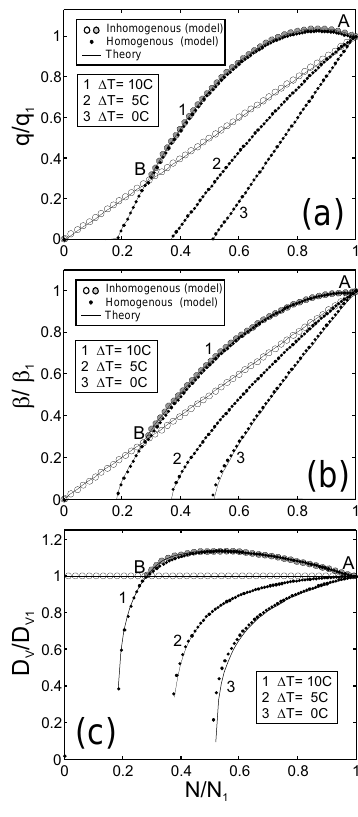
Figure 7. Effect of temperature difference between cloud and en- trained air on mixing. The calculations were performed for initial temperatures T 2 : (1) − 10 ◦ C; (2) − 5 ◦ C; (3) 0 ◦ C. Grey circles in- dicate extreme inhomogeneous mixing on line 1 at the AB inter- val. The rest cases on extreme inhomogeneous mixing are indi- cated by open circles. The initial conditions used for the calcula- tions were the following: H = 1000m, RH 2 = 90%; D 1 = 10µm, N 1 = 500cm − 3 , T 1 = 0 ◦